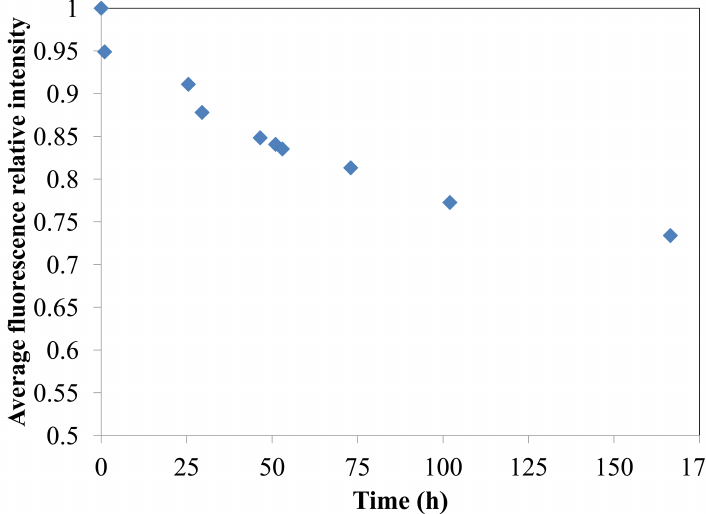
Figure 36. Average reflected-light intensity reduction with time for spun-fiber sample. From Samaha et al.